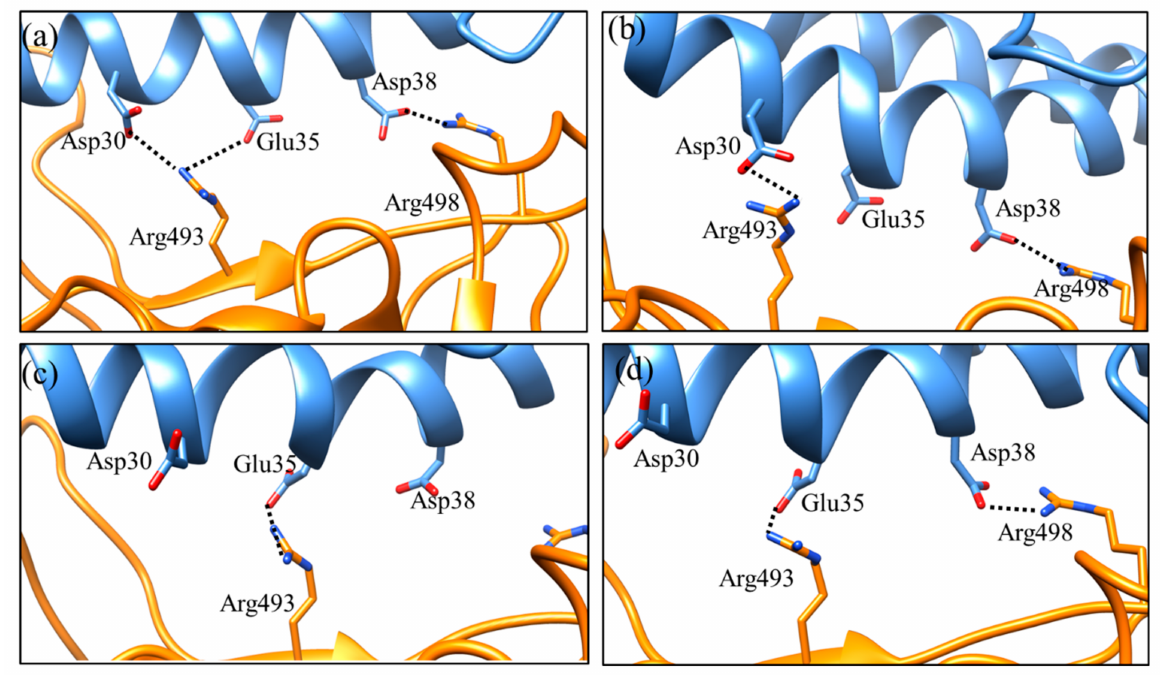
Figure 4. The electrostatic interaction involving residues and their interactions observed during MD simulation: ( a ) All possible salt bridge pairs Arg493 – Asp30, Arg493 – Glu35, and Arg498 – Asp38 observed during the entire 100 ns MD simulation, ( b ) the salt bridge pairs Arg493 – Asp30 and Arg498 – Asp38 observed between 0 and 70 ns of MD simulation, ( c ) the salt bridge pair Arg493 – Glu35 observed between 80 and 100 ns of MD simulation, and ( d ) the salt bridge pairs Arg493 – Glu35 and Arg498 – Asp38 observed for a very short time between 80 and 85 ns of MD simulation. The hACE2 receptor is shown in blue and the spike RBD by orange.